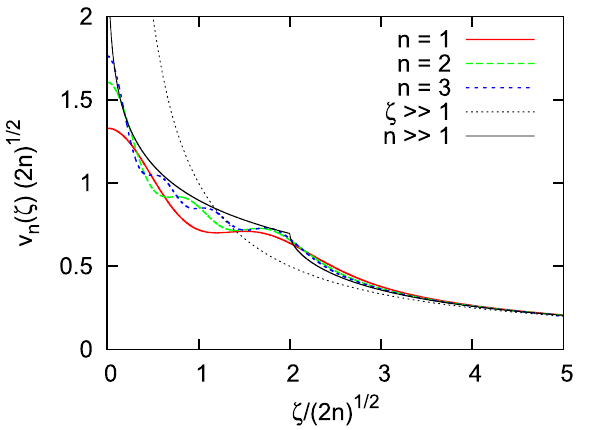
Figure 1. Interaction potentials calculated from Eq. (25) alongside the large- n [Eq. (26)] and large- ζ (Coulomb)